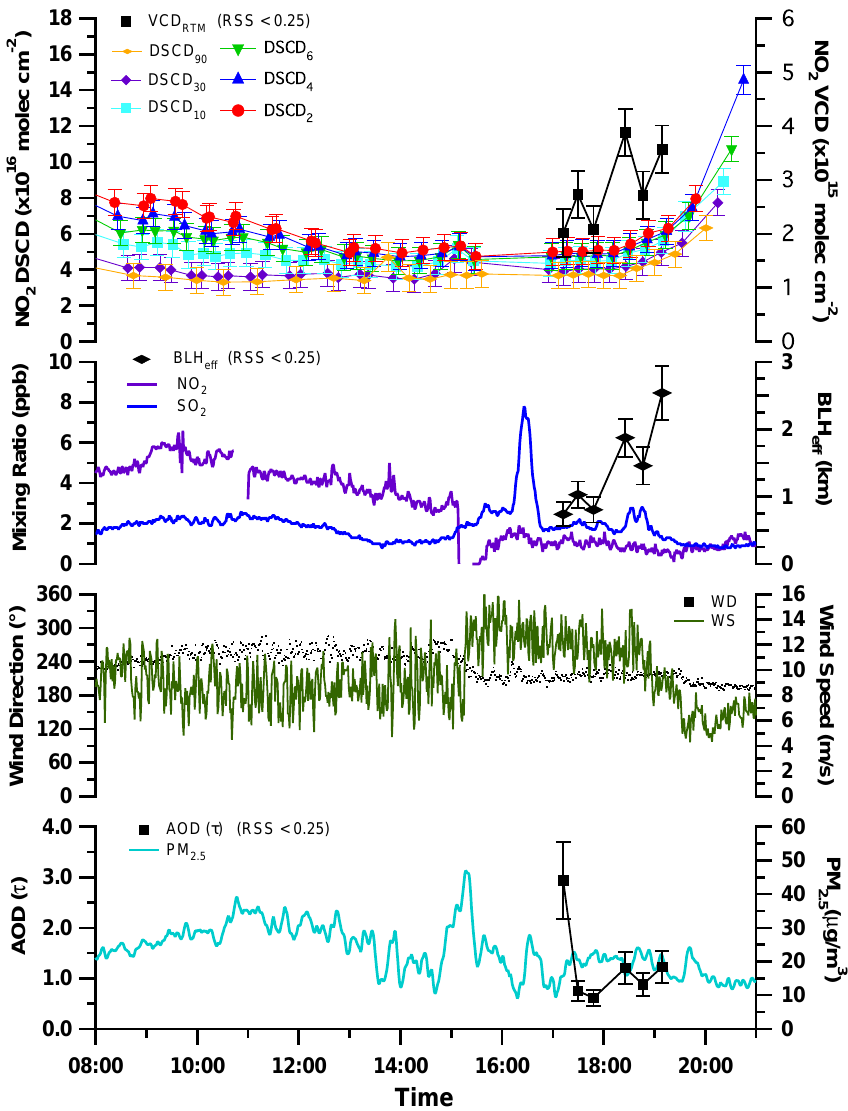
Fig. 16. Measurements at Ridgetown on 9 July 2007. NO 2 MAX-DOAS DSCDs with NO 2 VCD RTM values are followed by ground level measurements of SO 2 and NO 2 , BLH eff , wind direction, wind speed, PM 2 . 5 , and AOD ( τ RTM